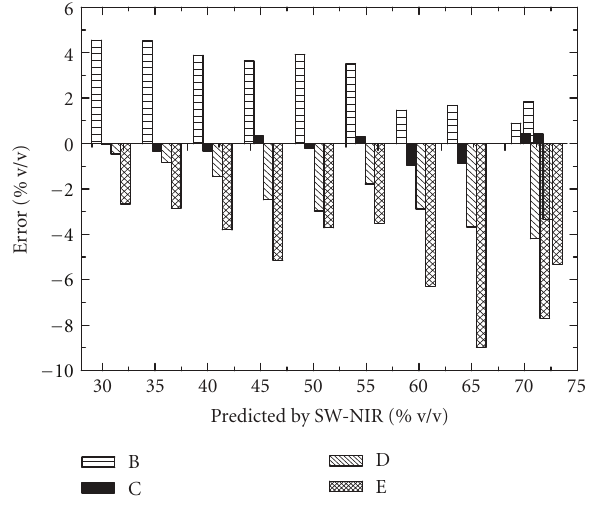
Figure 6: The prediction error for various temperature validations. B: validation set at 15 ◦ C; C: validation set at 25 ◦ C; D: validation set at 35 ◦ C; E: validation set at 40 ◦